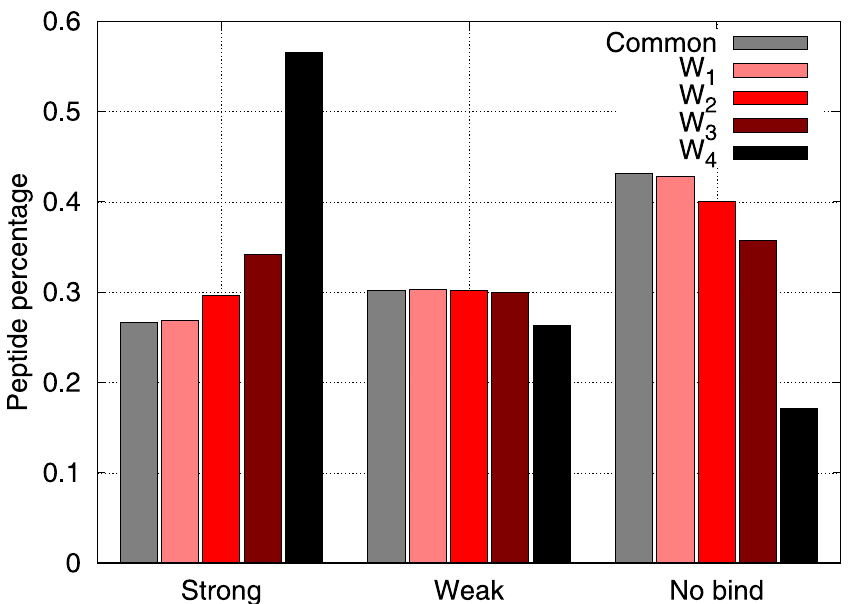
Fig 1. Percentages of MHC-I bound types (no bind, weak bind and strong bind) in the various peptide classes ( C , W 1 , W 2 , W 3 and W 4 ) for Trypanosoma cruzi ( TC ) unique